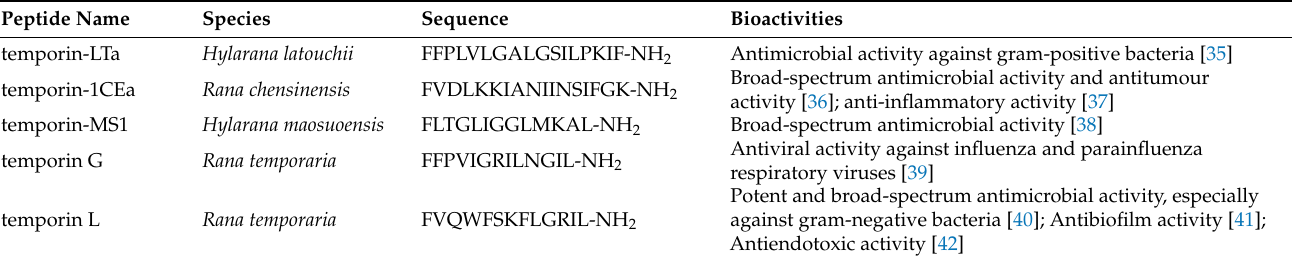
Table 1. The sequences and bioactivities of several peptides in the temporin family.